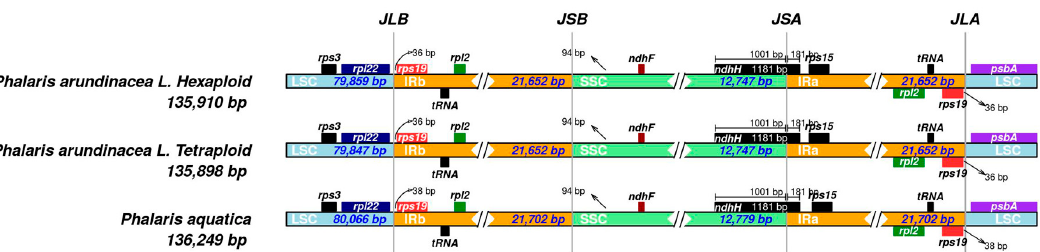
Figure 4. IRscope analysis of the three Phalaris cp genomes. JLB, junction of LSC and IRB region; JSB, junction of SSC and IRB region; JSA, junction of SSC and IRA region; JLA, junction of LSC and IRA region.